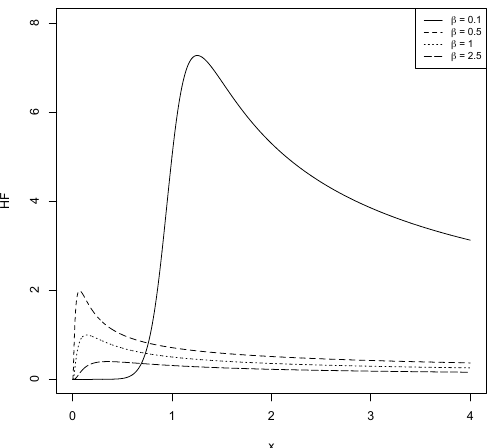
Figure 4. The HF for the LBS distribution with different values for β and α =